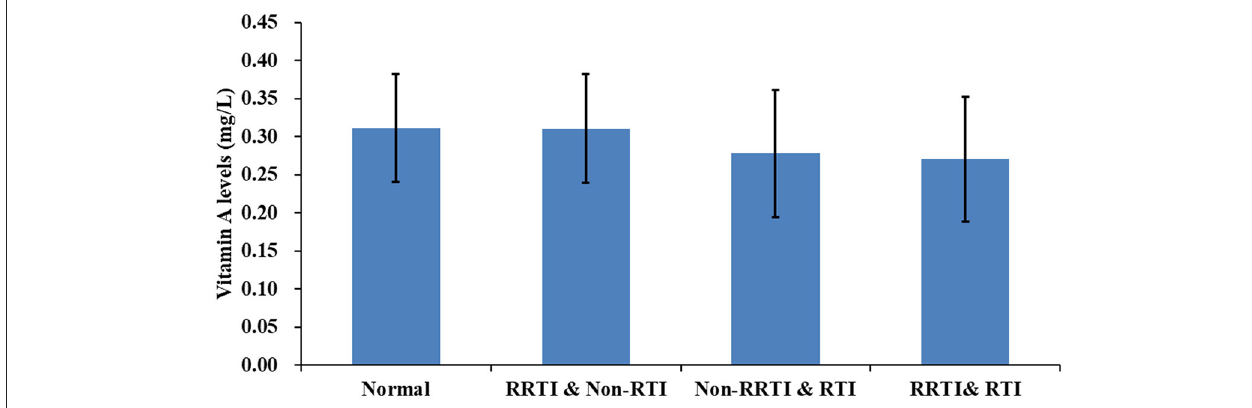
FIGURE 1 | Histogram of vitamin A levels in children with recurrent respiratory infections and normal children.